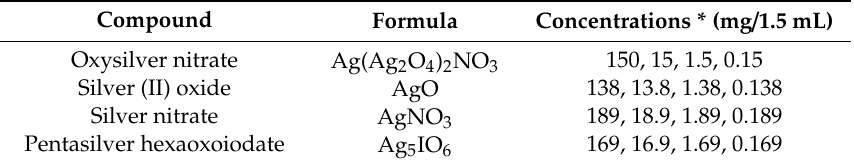
Table 4. Silver solutions used in this